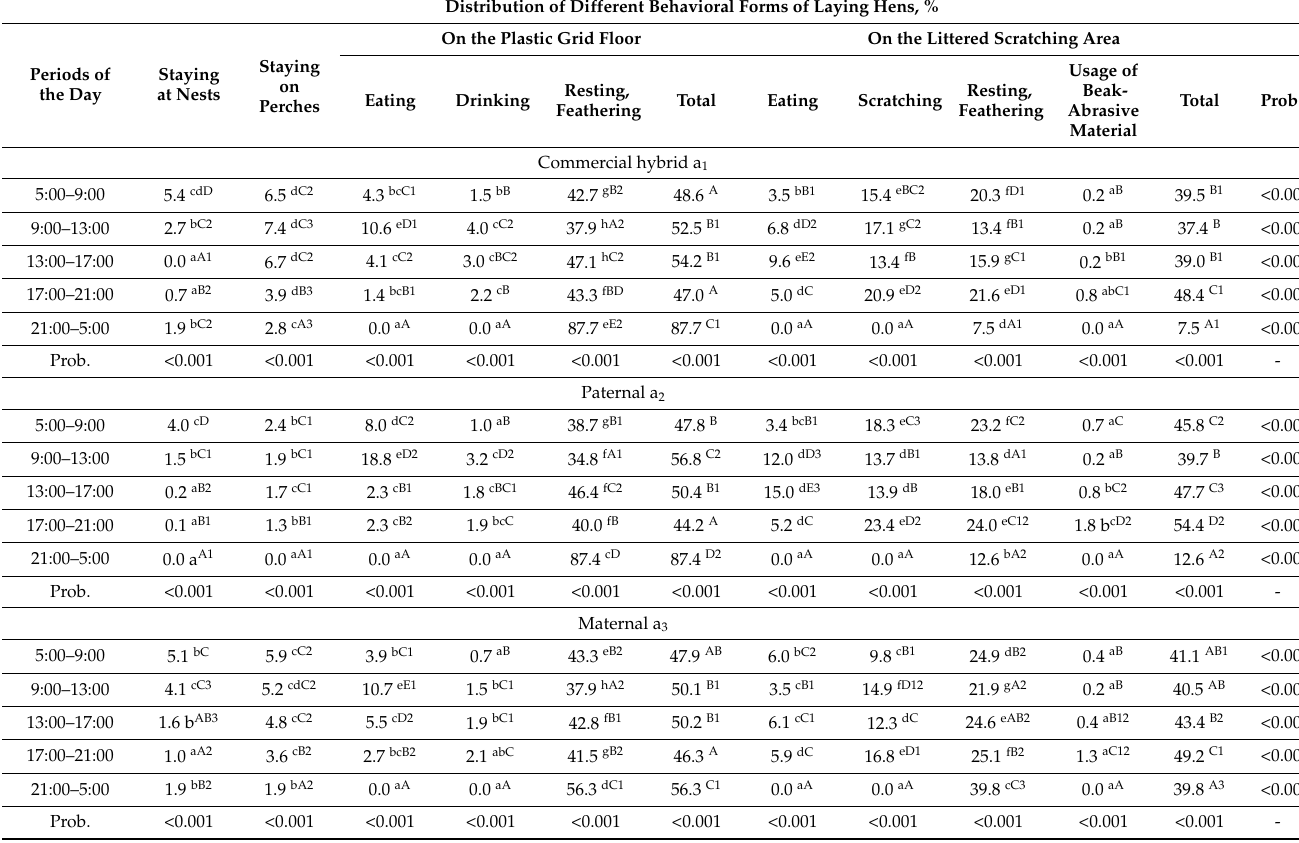
Table 3. Distribution of different behaviors (%) in several parts of the pen depending on genotype and period of the day. Distribution of Different Behavioral Forms of Laying Hens,